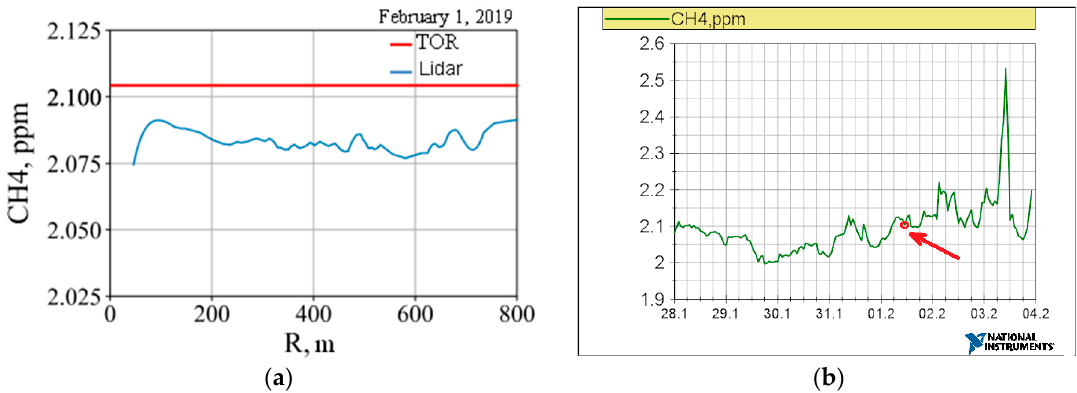
Figure 10. CH 4 concentration measured along a 800-m surface atmospheric path with a spatial resolution of 100 m ( a ) and at the tropospheric ozone research (TOR) station of IAO SB RAS ( b ).